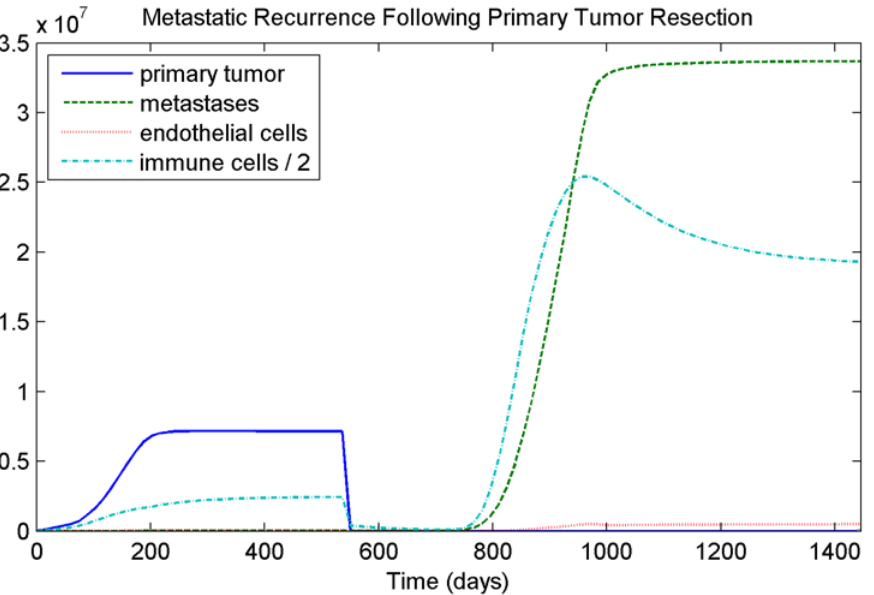
Figure 7. Resection followed by metastatic recurrence. The primary tumor is held to a steady state and metastases are present at undetectable levels prior to resection. Following resection, aggressive metastatic recurrence occurs. The asymptotic behavior of the metastases is the same as the primary tumor (i.e. steady state), but the overall growth rate is faster, and the final cancer load is much greater.